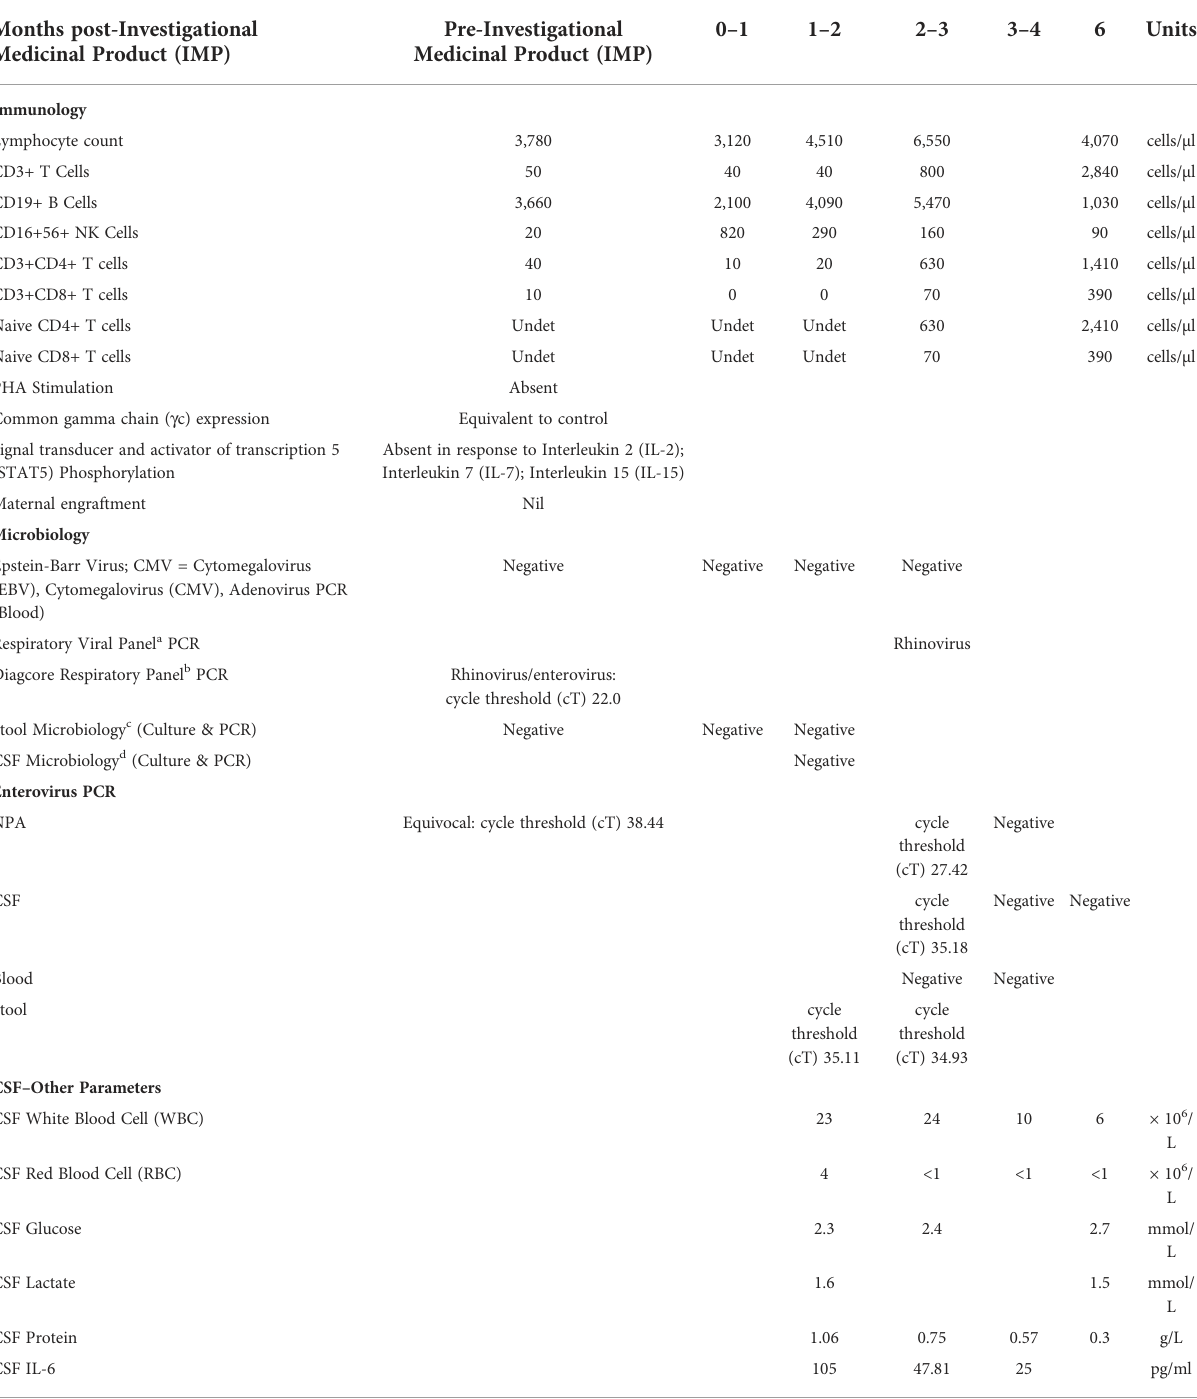
TABLE 1 Relevant laboratory parameters pre- and at various time points